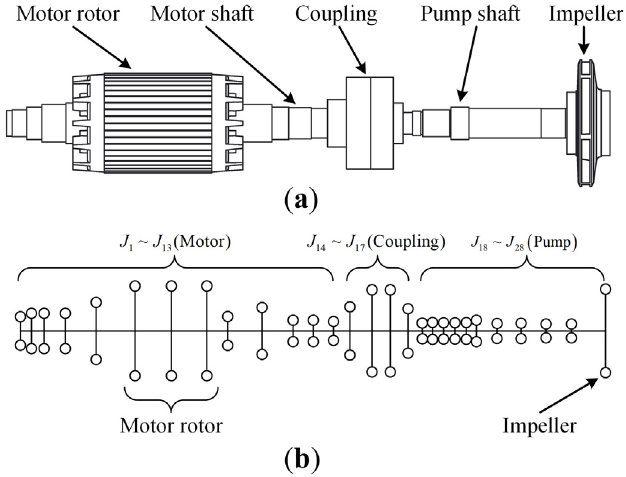
Fig. 9. Lumped parameter model of the centrifugal pump